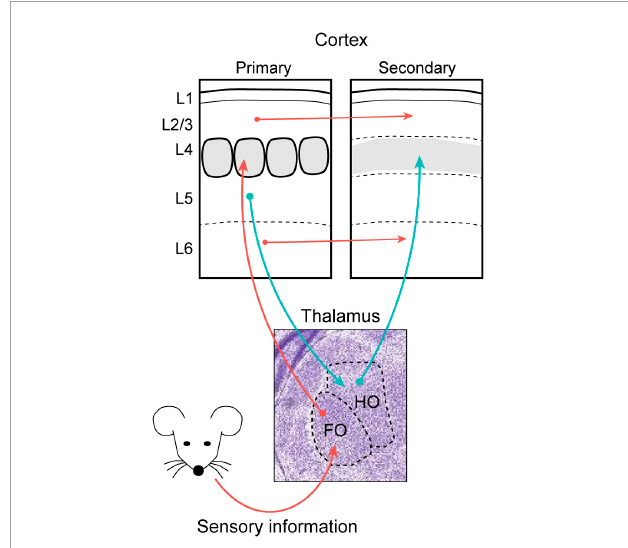
FIGURE1 The thalamus transmits peripheral sensory information to primary sensory areas and retransmits the processed sensory message to secondary cortical areas. The schema represents the major feed-forward connections of the mouse whisker system. Stimuli from peripheral sensory organs arrive at first order thalamic nuclei (FO) which connects with L4 neurons in the primary sensory cortex. The information then spreads to other cortical areas both through direct cortico-cortical connections (red arrows) and through the trans-thalamic pathway using higher-order thalamic nuclei (HO) as relay stations (blue